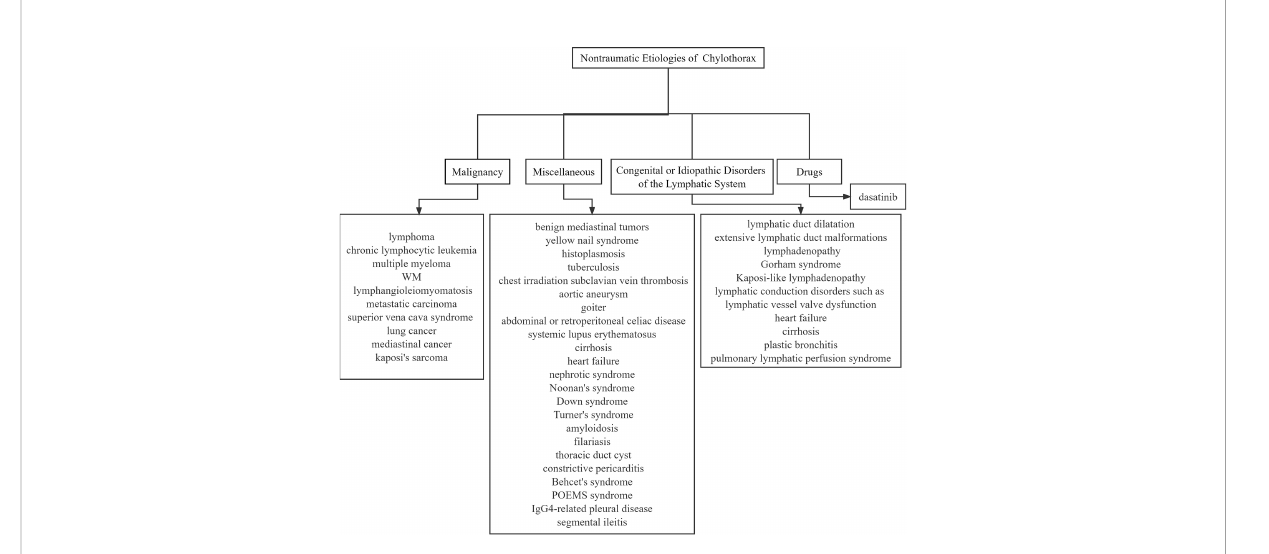
FIGURE 3 Nontraumatic etiologies of